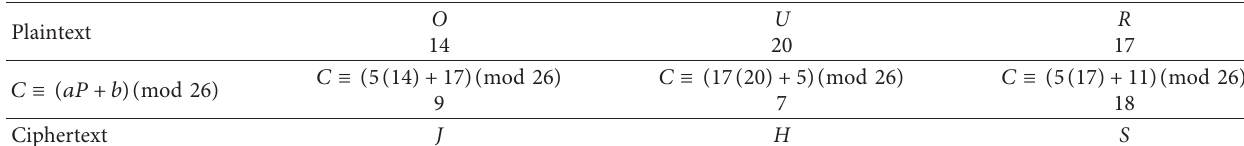
Table 6: Solution on the evaluated affine transformation, C ≡ ( aP + b )( mod 26 ) .